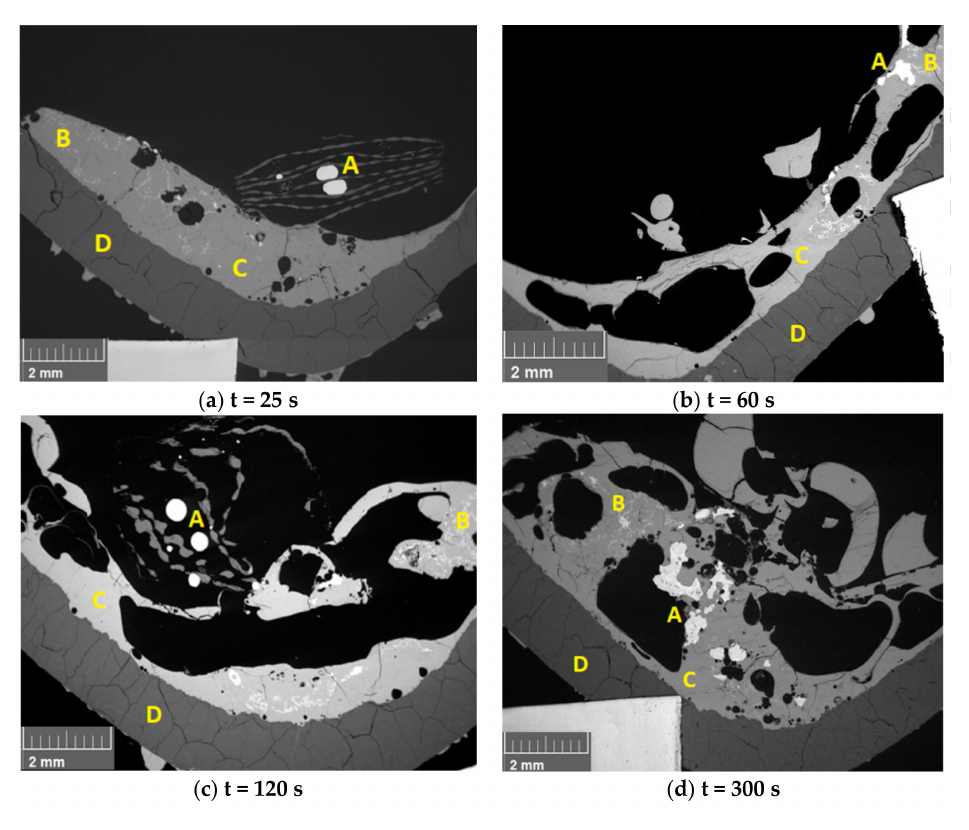
Figure 3. Scanning electron microscope (SEM)—backscattered electron (BSE) micrographs of the waste PCB (WPCB) specimens at different melting times. The letters indicate ( a ) metal droplets from PCB, ( b ) unreacted iron from the slag mixture, ( c ) liquid slag, and ( d ) silica